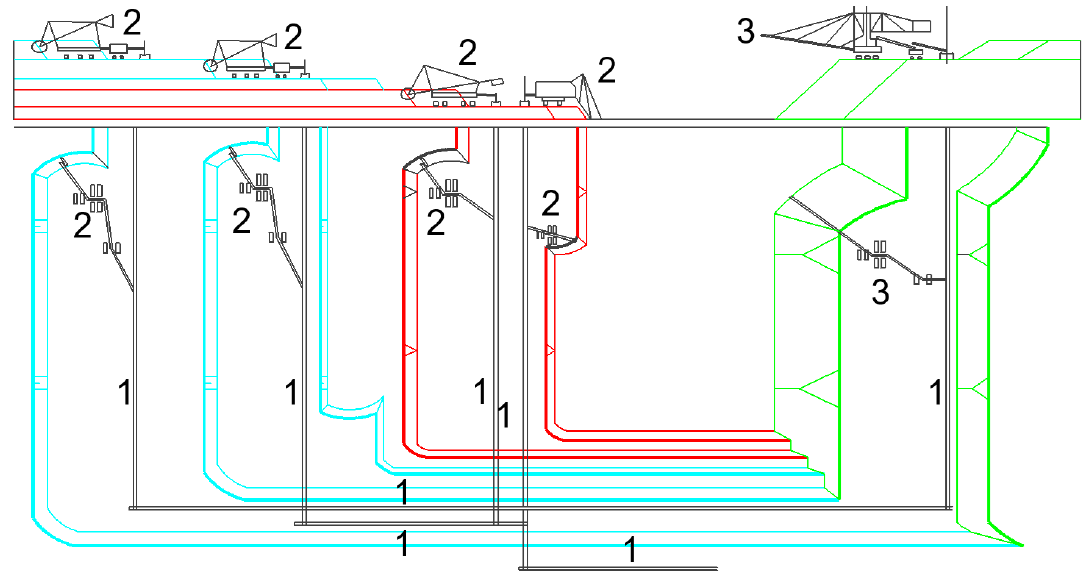
Figure 1. Schematic cross-section and a plan view of the lignite surface mine: 1—belt conveyor routes, 2—excavators, 3—spreader; blue lines—overburden mining levels, red lines—lignite mining levels, green lines—in-pit dumping level.